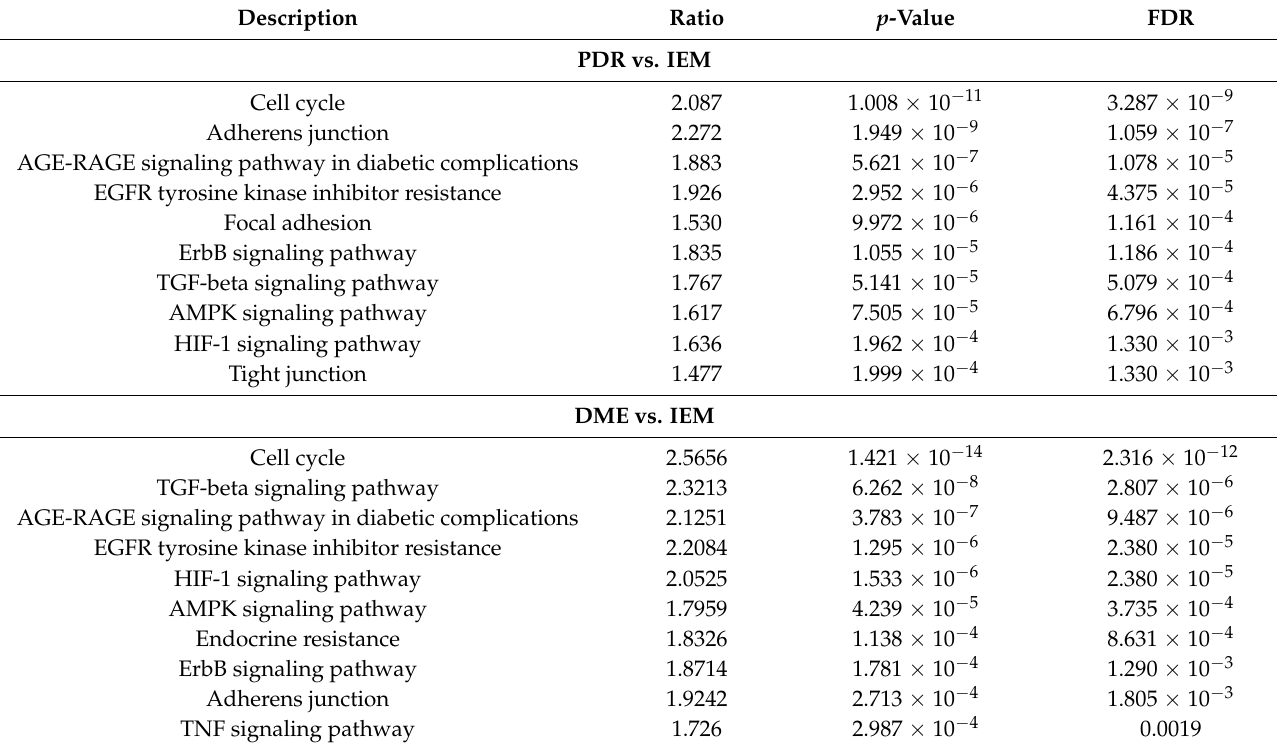
Table 3. Enriched pathways based on the target genes under the regulation of miRNAs with differen- tial expression, found through TLDAs